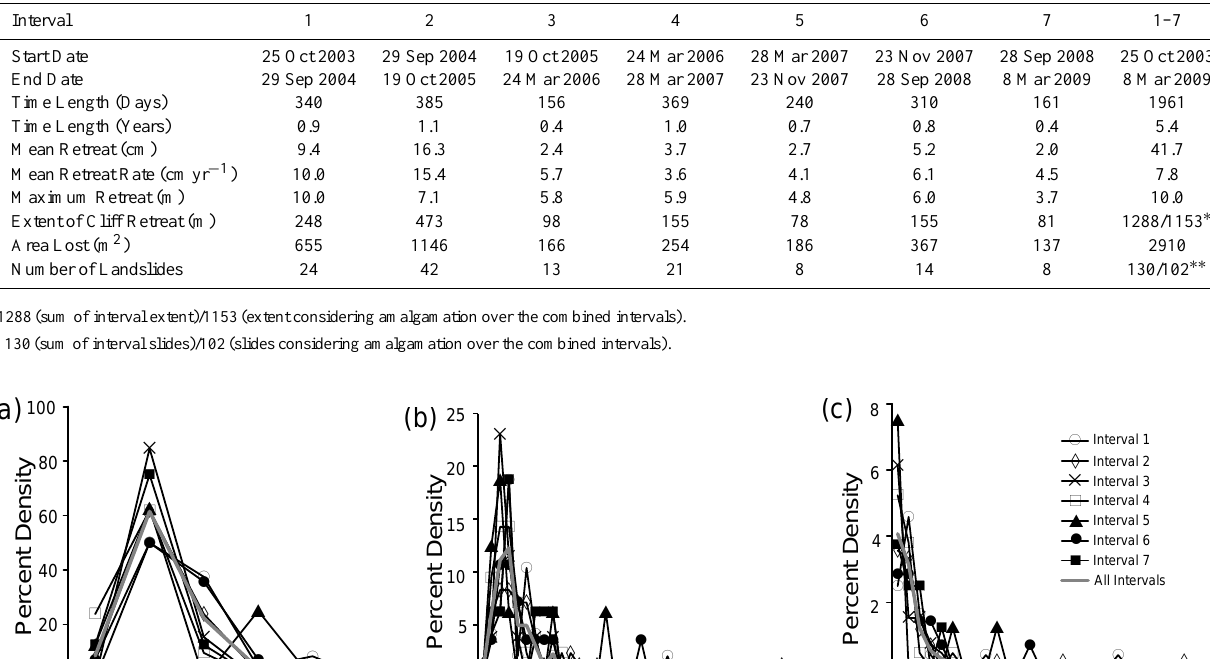
found by Marques (2008). Unimodal cliff failure probability density functions (Fig. 7), and power-law